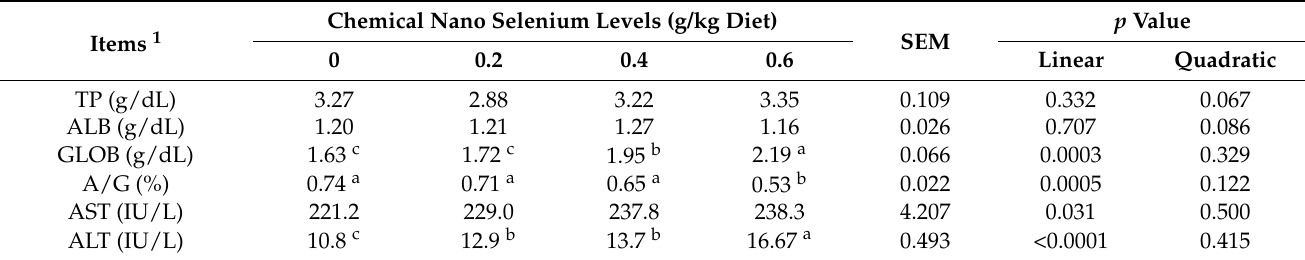
Table 7. Liver and kidney function of growing Japanese quail as affected by dietary